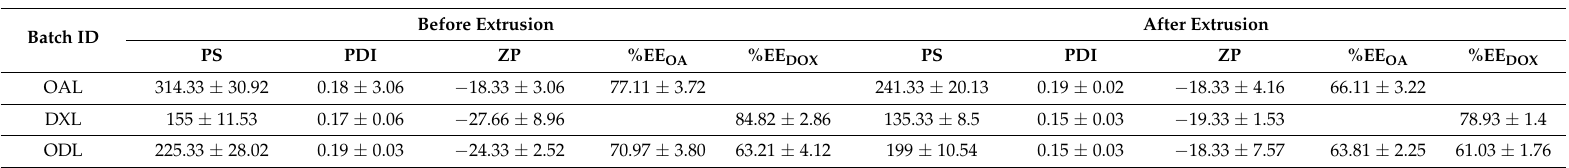
Table 1. Physicochemical attributes of liposomal formulations developed by TFH method ( n = 3); HSPC:CHOL:DSPE.PEG 2000 (57:38:5, molar ratio), Drugs:Lipids (1:8, molar ratio), Temp. (48 ◦ C), (OA:DOX, 5:1, w / w )(mean ±